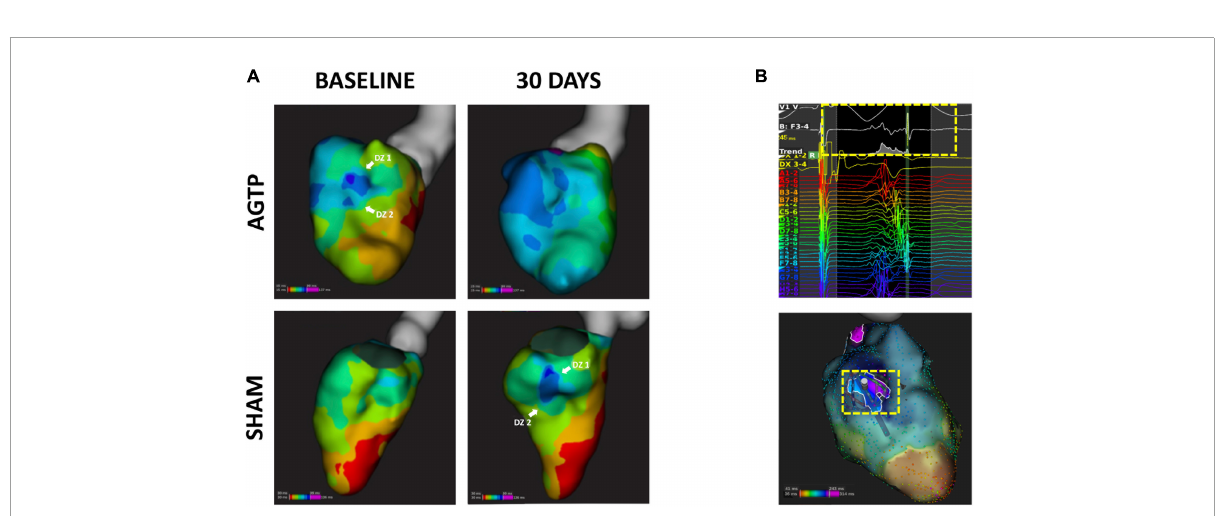
FIGURE5 Isochronal mapping and deceleration zones. Representative isochronal activation maps of AGTP (top) and sham-surgery (bottom) animals; the AGTP group showed significant reduction in the number of deceleration zones over time, whereas an increase was observed in the sham subjects (A) . (B) Illustrates an example of a follow-up high density map of a sham subject exhibiting a late and fractionated electrogram (yellow box) at the latest activation area (infero-basal left ventricular